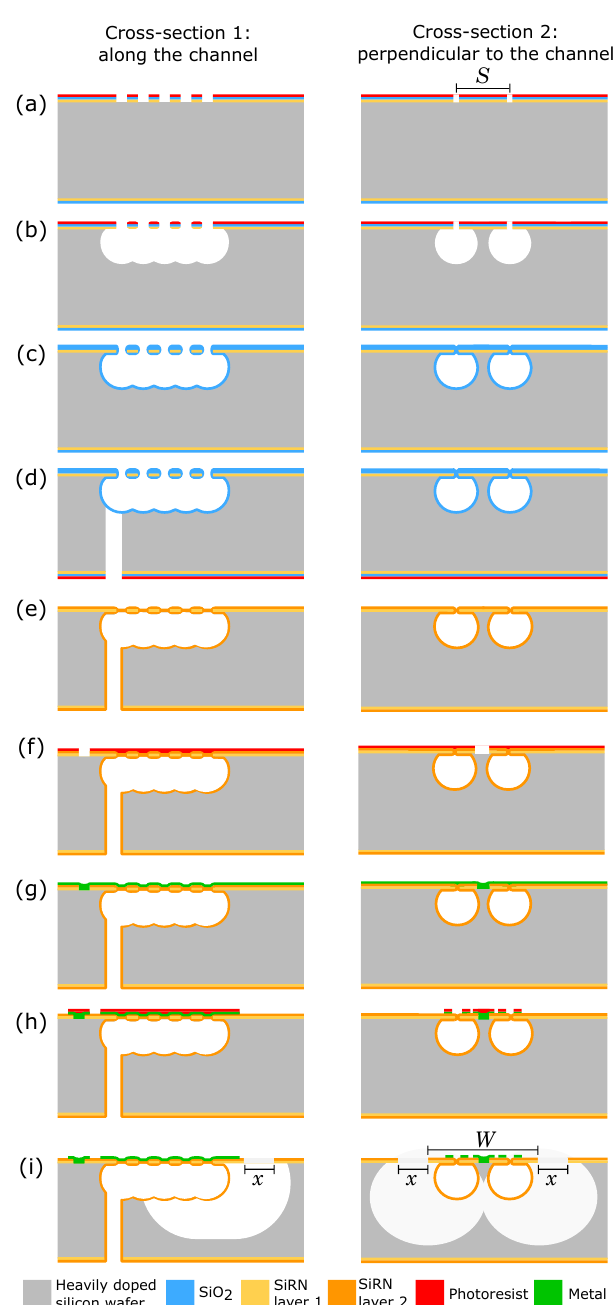
Figure 2. The modified SCT fabrication process is schematically illustrated in cross-sectional views along the channel length (cross-section 1) and perpendicular to the channel (cross-section 2). ( a ) Start with a heavily doped silicon wafer. RIE is used to etch SiO 2 and SiRN to form two rows of slits with spacing S ; ( b ) semi-isotropic RIE the silicon through the slits. If S is designed properly, two separate microchannels will be formed; ( c ) deposit SiO 2 using LPCVD; ( d ) RIE is used to etch SiO 2 and SiRN at the backside of the wafer. Bosch-based DRIE of the inlet and outlet holes until reaching SiO 2 ; ( e ) wet etching of SiO 2 using HF. Seal the slits and form SiRN channel walls using LPCVD. ( f ) Etch SiRN above the silicon sidewall electrode (cross-section 2) and the device grounding (cross-section 1) using RIE; ( g ) sputtering of and ( h ) IBE the metal thin films for electrical interconnections; ( i ) etching of the release windows of width x by directional RIE and releasing the channels by isotropic RIE. If the width W of the flat SiRN membrane above the microchannels is designed properly, a silicon sidewall electrode will remain between the